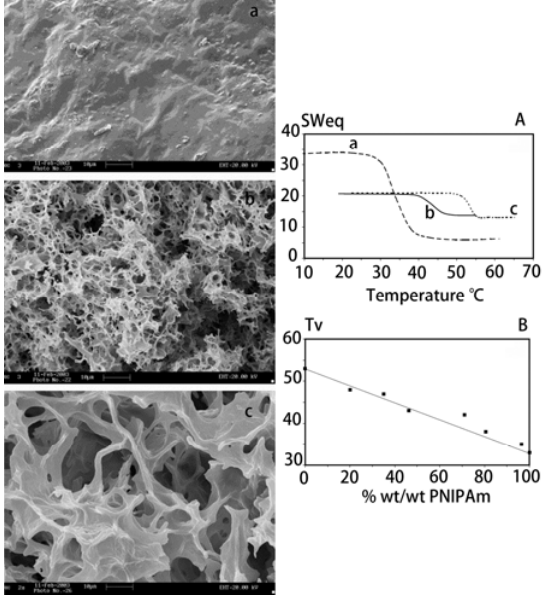
Figure 17. Left: SEM images of freeze-dried gels; Right: ( A ) Equilibrium swelling degree (SWeq) vs. temperature; ( B ) Temperature of the volume phase transition T HPC/PNIPAm-IPN having different composition. ( a ) PNIPAm; ( b ) HPC/PNIPAm interpenetrated network (composition of 53.7/46.3 wt/wt); ( c ) HPC. Reprinted with permission from [56]. Copyright 2004